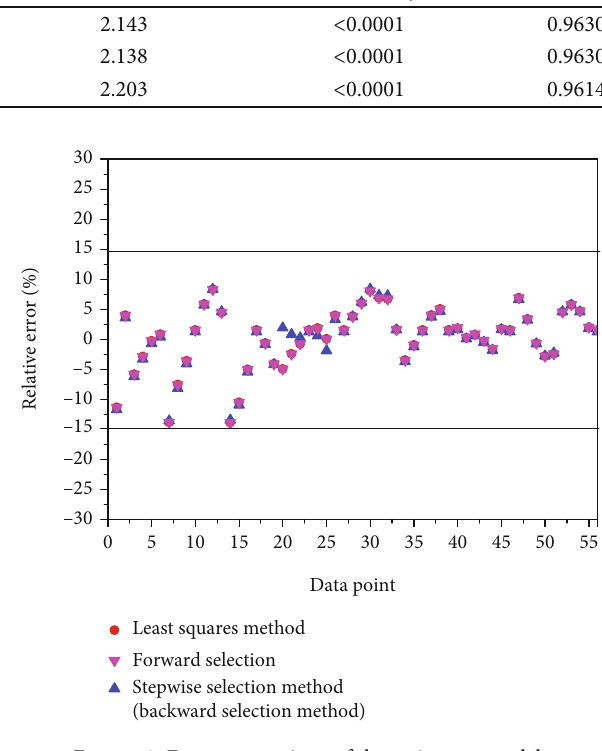
Figure 3: Error comparison of the resistance model. Table 6: Error analysis of the resistance